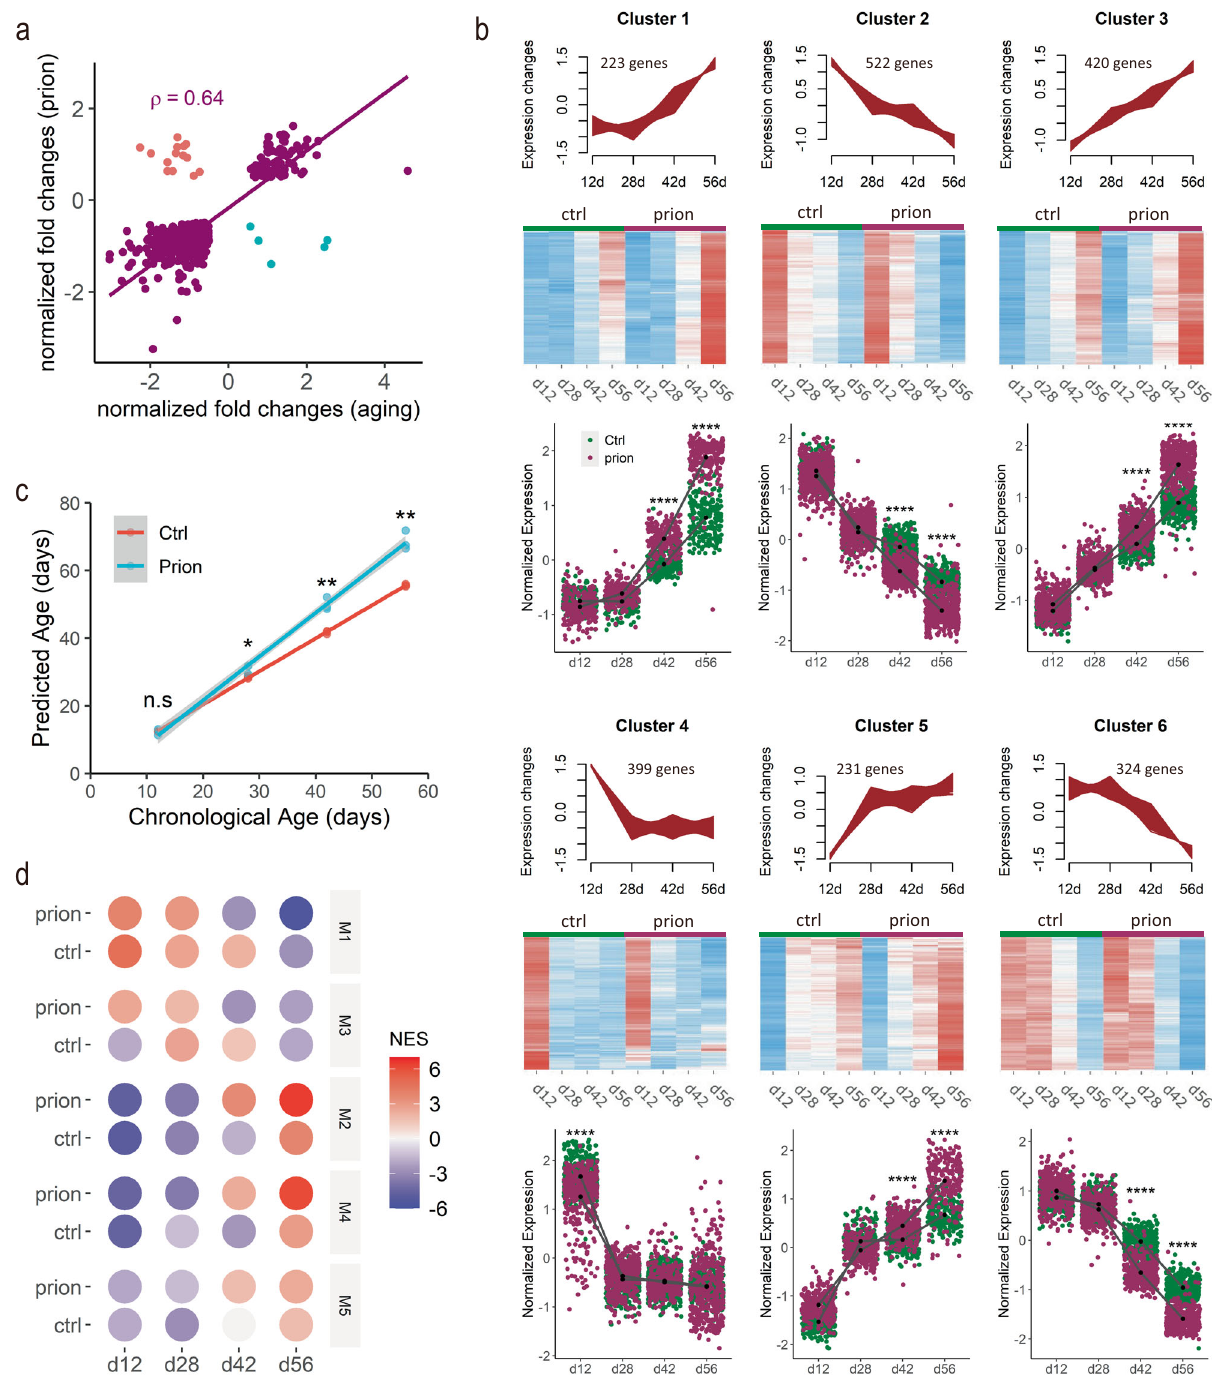
Fig. 3 Prions accelerate biological aging in COCS. a Normalized fold changes of DEG commonly identi fi ed in prion-exposed and naturally aged COCS. ρ : Spearman ’ s correlation coef fi cient. Genes show different directions of changes in the two conditions are highlighted in cyan or red. b Upper panel of each cluster: graphs showing the aging-associated gene clusters classi fi ed by fuzzy c-means. Only those genes with cluster membership values >0.5 are shown. Middle panel for each cluster: heatmaps showing the relative expression levels of clustered genes in the presence and absence of prions. Bottom panel for each cluster: quanti fi cations of normalized expression levels of clustered genes in the presence and absence of prions. **** p < 0.0001. c Linear regression of chronological and predicted biological ages of NBH- (Ctrl) and prion-exposed COCS at different time points. Shading indicates 0.95 con fi dence interval. * p < 0.05, ** p < 0.01. n.s not signi fi cant. d Heatmap showing the transcriptional activities of the fi ve gene co-expression network-modules in NBH- (Ctrl) and prion-exposed COCS over time. NES: normalized enrichment score of gene set enrichment